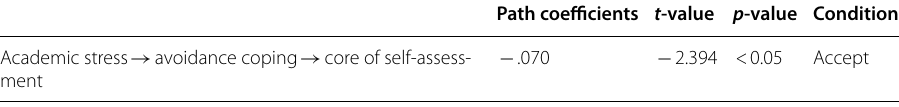
Significant at the level of 0.01 ( p <